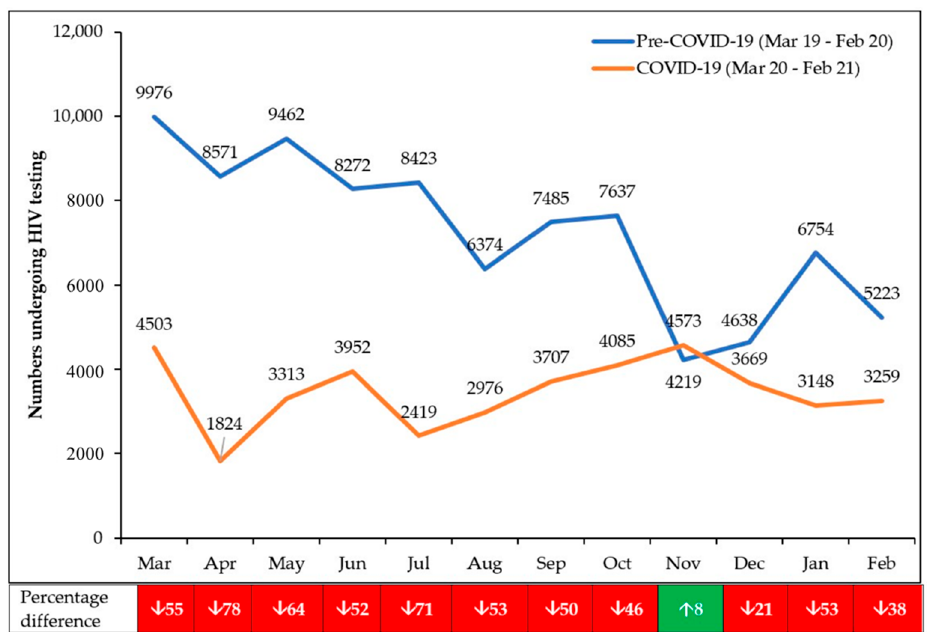
Figure 4. Monthly numbers presenting each month for HIV testing in 10 health facilities in Harare, Zimbabwe, during pre-COVID-19 and COVID-19 periods; ↑ = increase; ↓ = decrease. From